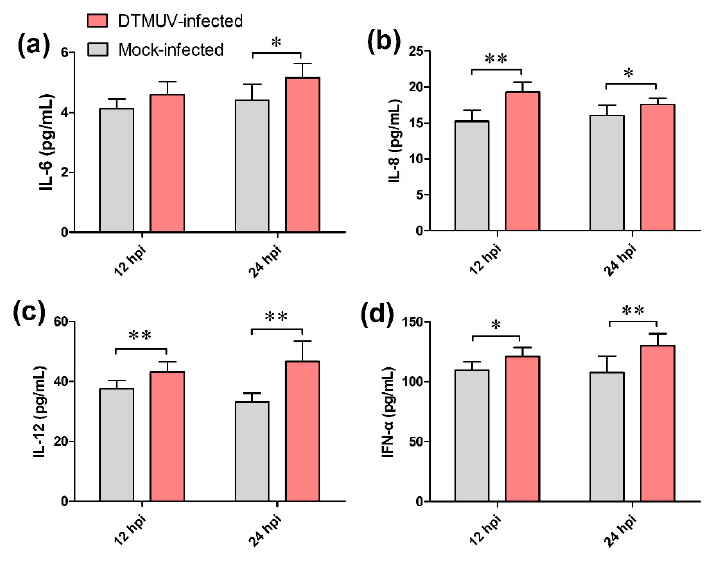
Figure 10. Concentrations of IL ‐ 6 ( a ), IL ‐ 8 ( b ), IL ‐ 12 ( c ), and IFN ‐α ( d ) in the culture supernatant of the mock ‐ and duck Tembusu virus (DTMUV) ‐ infected groups. The data are presented as the mean ± mock- and duck Tembusu virus (DTMUV)-infected groups. The data are presented as the mean ± standard standard deviation ( n = 6). * p < 0.05, ** p < 0.01. deviation ( n = 6). * p < 0.05, ** p <